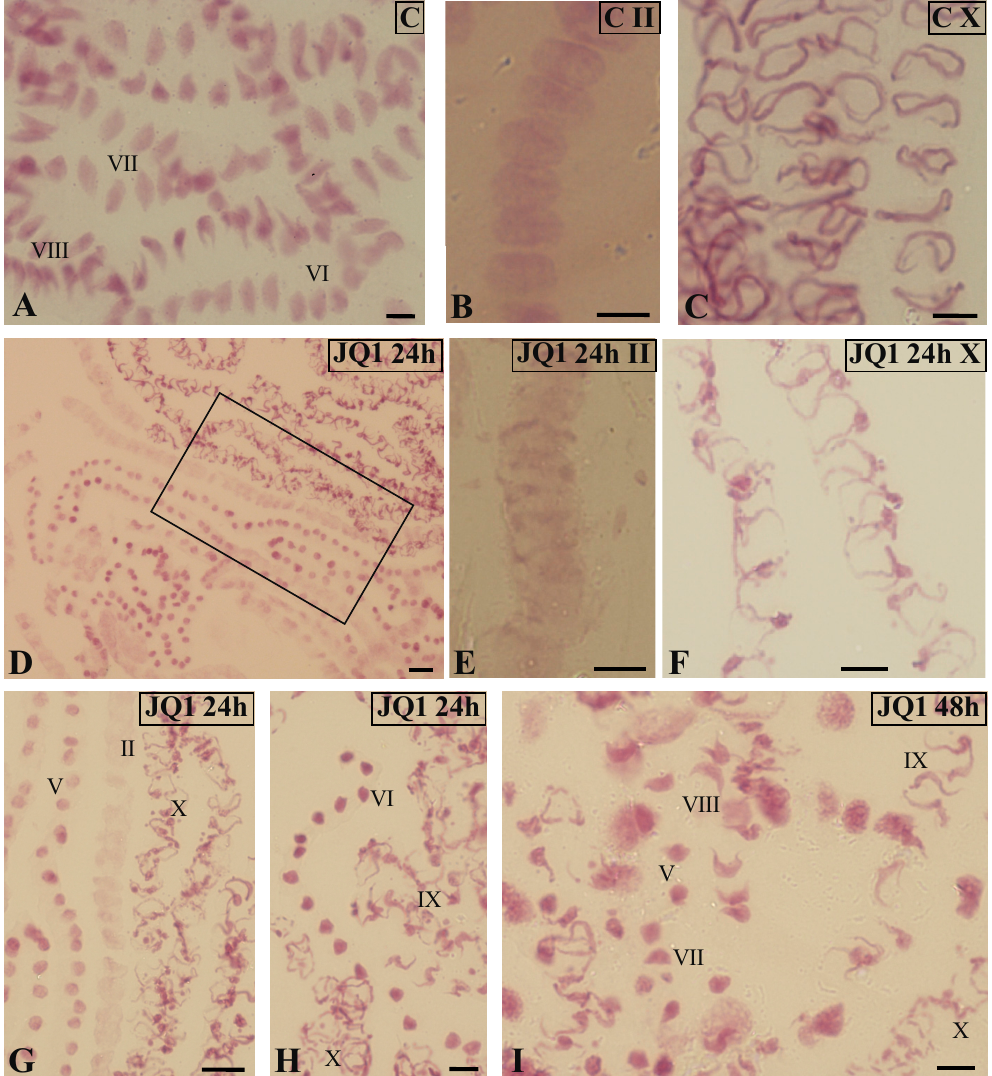
Figure 2. Feulgen-stained spermatid nuclei at antheridial filaments of C. vulgaris spermiogenesis.